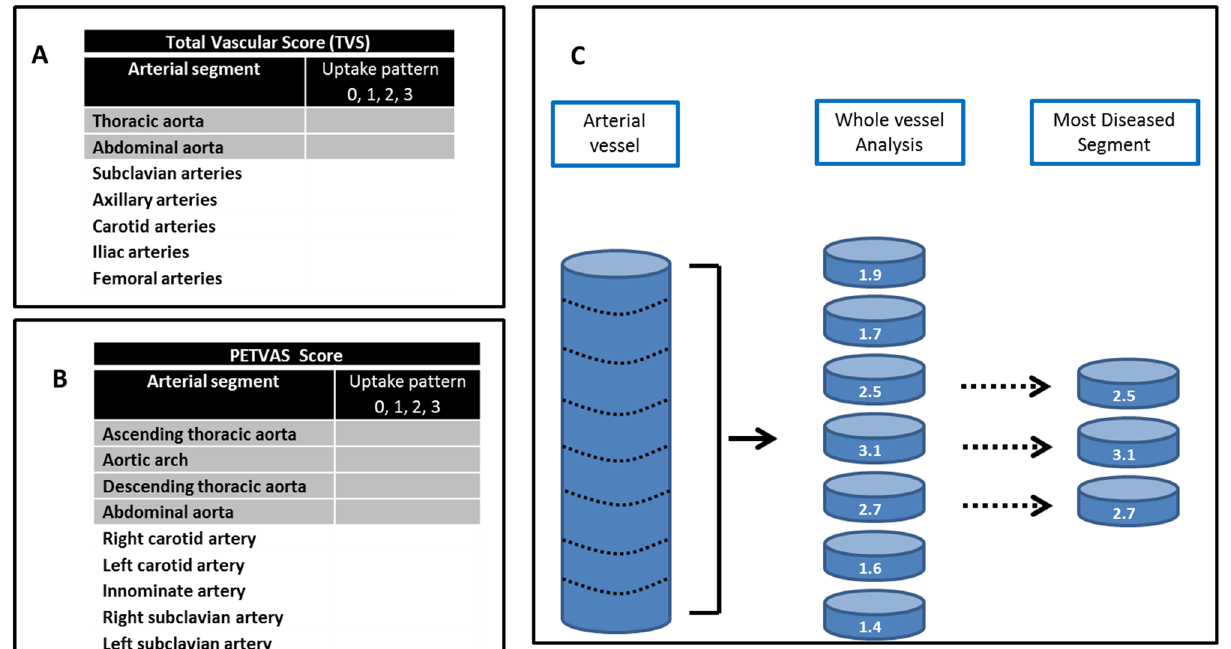
Figure 3. Total vascular score ( A ), PETVAS score, ( B ) and most diseased segment analysis ( C ). TVS and PETVAS are calculated by summing the highest FDG uptake pattern of each arterial segment presented in Table A and